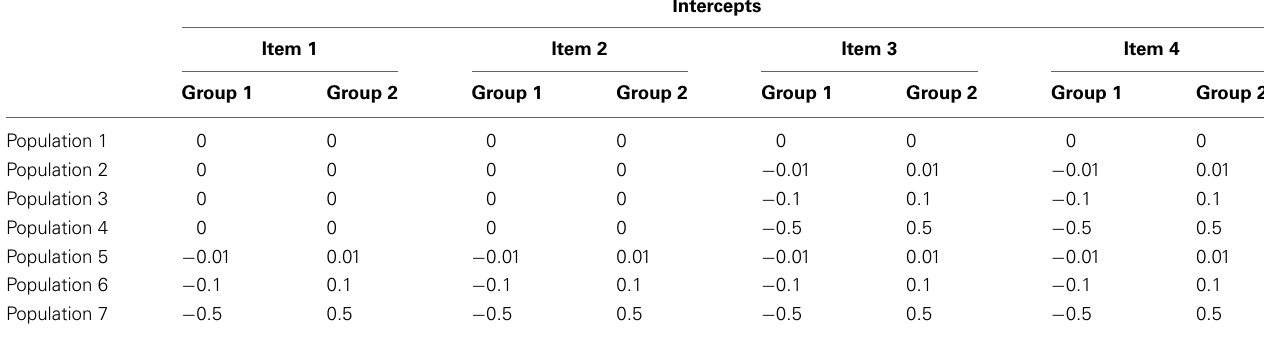
Table 3 | Population values for the